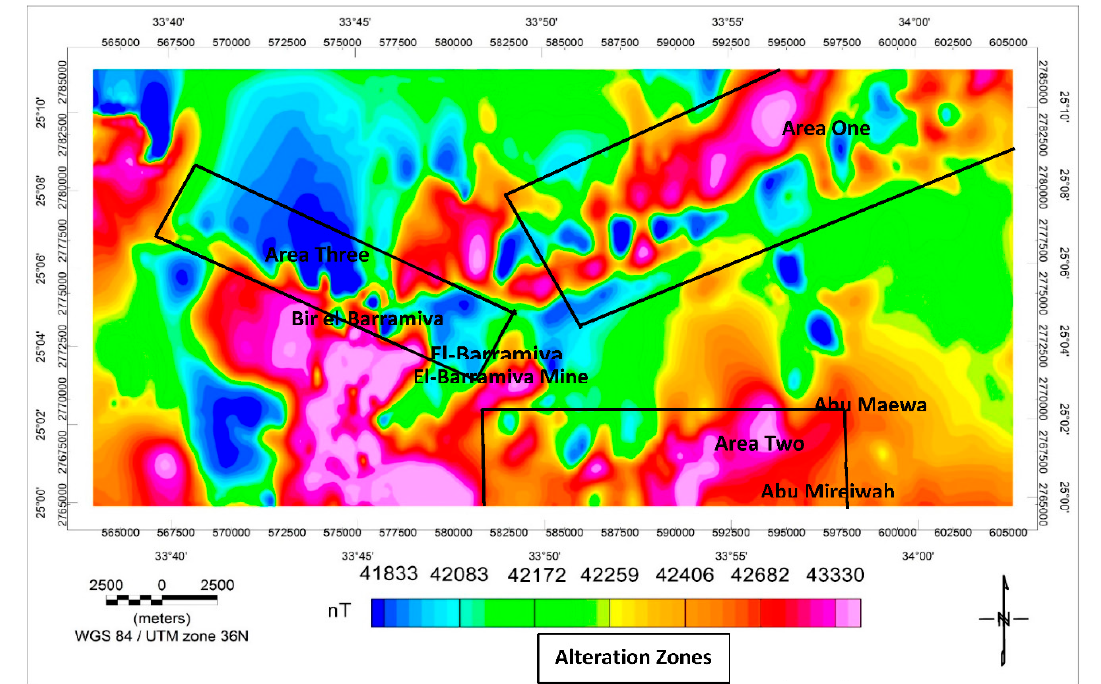
Figure 3. RTP magnetic map of the research area. The significant magnetic anomalies (pink color) in the northeastern portion of the study region are attributed to the mineralization belt (Barramiya-Um Saltit belt) linked with the NE-SW running faults. Low magnetic anomalies (blue color) are found throughout the area, but they extend in three directions: NE–SW, NW–SE, and N–S, which could be related to the sedimentary cover and calc-alkaline rocks. The area is highly deformed and sheared and includes different alteration zone according to our results from the aeromagnetic data and [28]. Area one is shown on the RTP map, representing the first alteration zone where it is located in the northeast and extends in the NE–SW direction parallel to the Gulf of Suez trend. Area two is the second alteration zone, extending in the E–W. Related to the strike-slip faults and transgressed thrust faults, this trend represents the Mediterranean trend and the major ductile shear zones that occur in the central part, coinciding with the Arabian Nubian shield collision with the Nile Craton in the west [29,30]. Our geophysical approach has also identified a third alteration zone, located in the western half of the study region next to the Barramiya mine and stretching in a northwest-southeast direction parallel to the Red Sea trend. The RTP magnetic data’s radially averaged power spectrum is split into three parts, as shown in Figure 4: regional (deep) sources, residual (shallow) sources, and